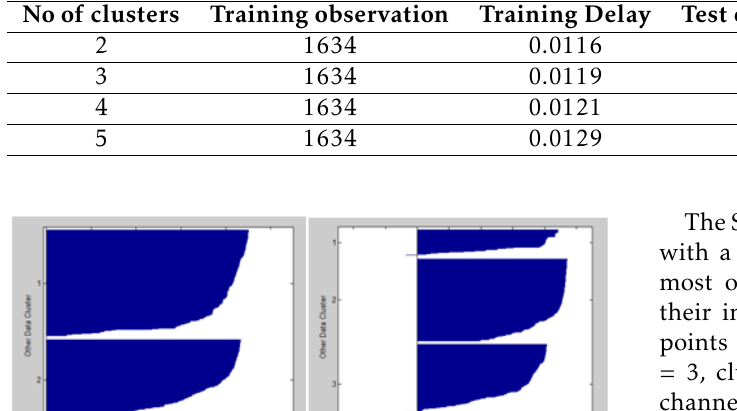
Table 2. Performance Summary of k-means clustering based CSS scheme using Cityblock Distance metric